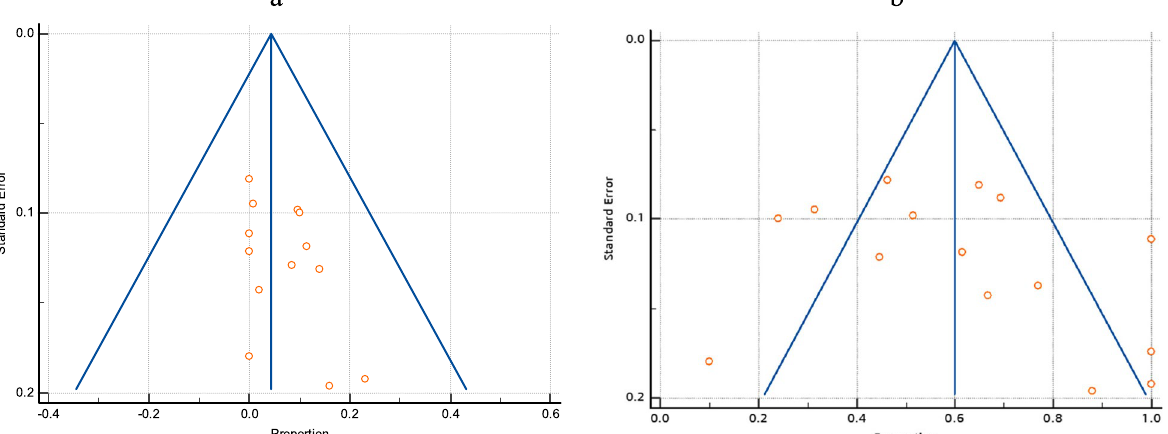
Fig. 10 Funnel plots of the resistance profile of the enterococcal isolates to linezolid and ampicillin. a Funnel plot of linezolid resistance. b Funnel plot of resistance